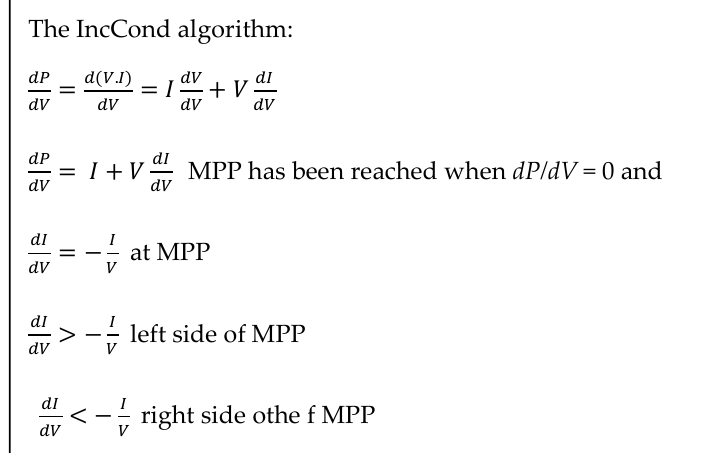
Figure 7. IncCond algorithm relations for Figure 8 flowchart.